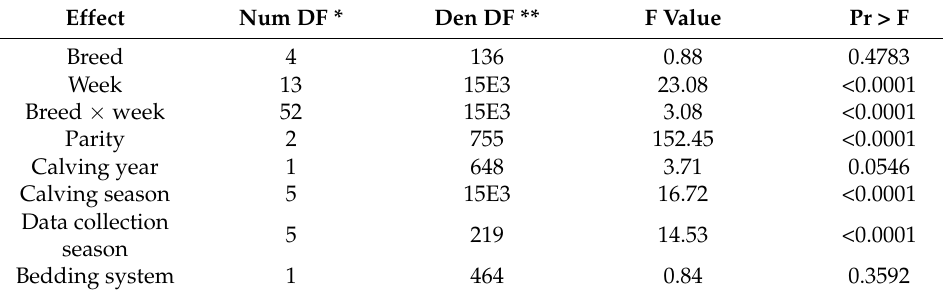
Table A13. Variance analysis results for the variable protein